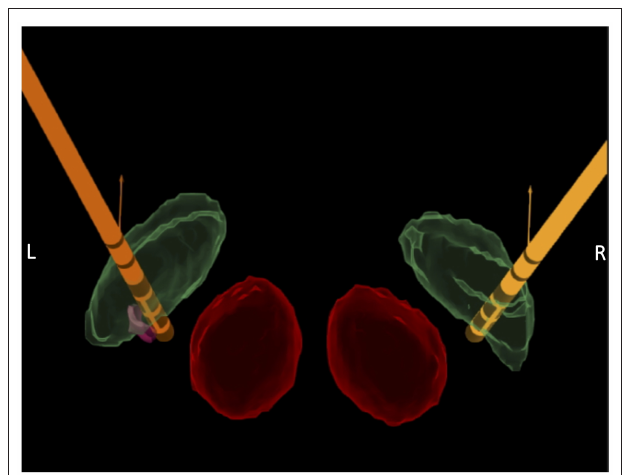
FIGURE 2 | Lead location confirmation. Fusion of postoperative CT scan with preoperative 3T axial MRI, using Elements © software (Brainlab © ) and Guide XT © software (Boston Scientific, Valencia, California), showing the final position of bilateral directional leads (orange) within the subthalamic nucleus (STN; green) and the red nucleus (red). The left lead was slightly medialized inside the STN and a small volume of tissue activated (VTA; pink sphere) was generated close to contact 3, to highlight its position in the ventromedial region of the nucleus.